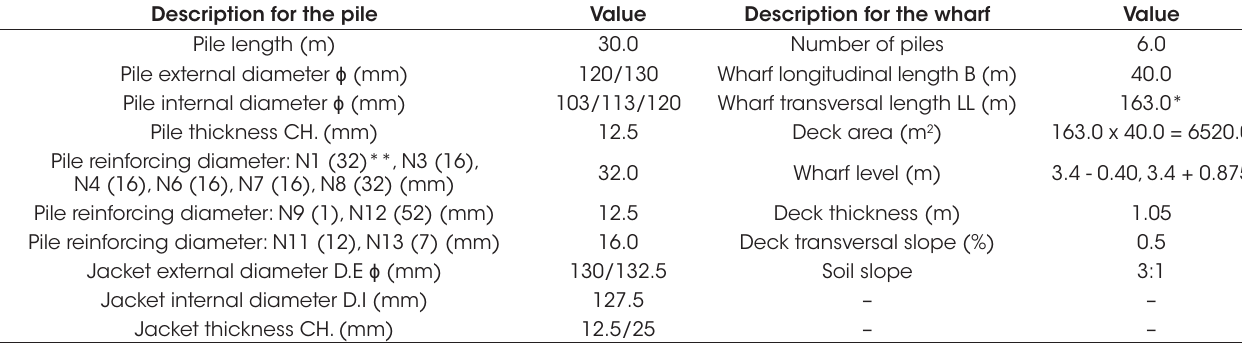
Data summary of the pile-supported wharf Description for the pile